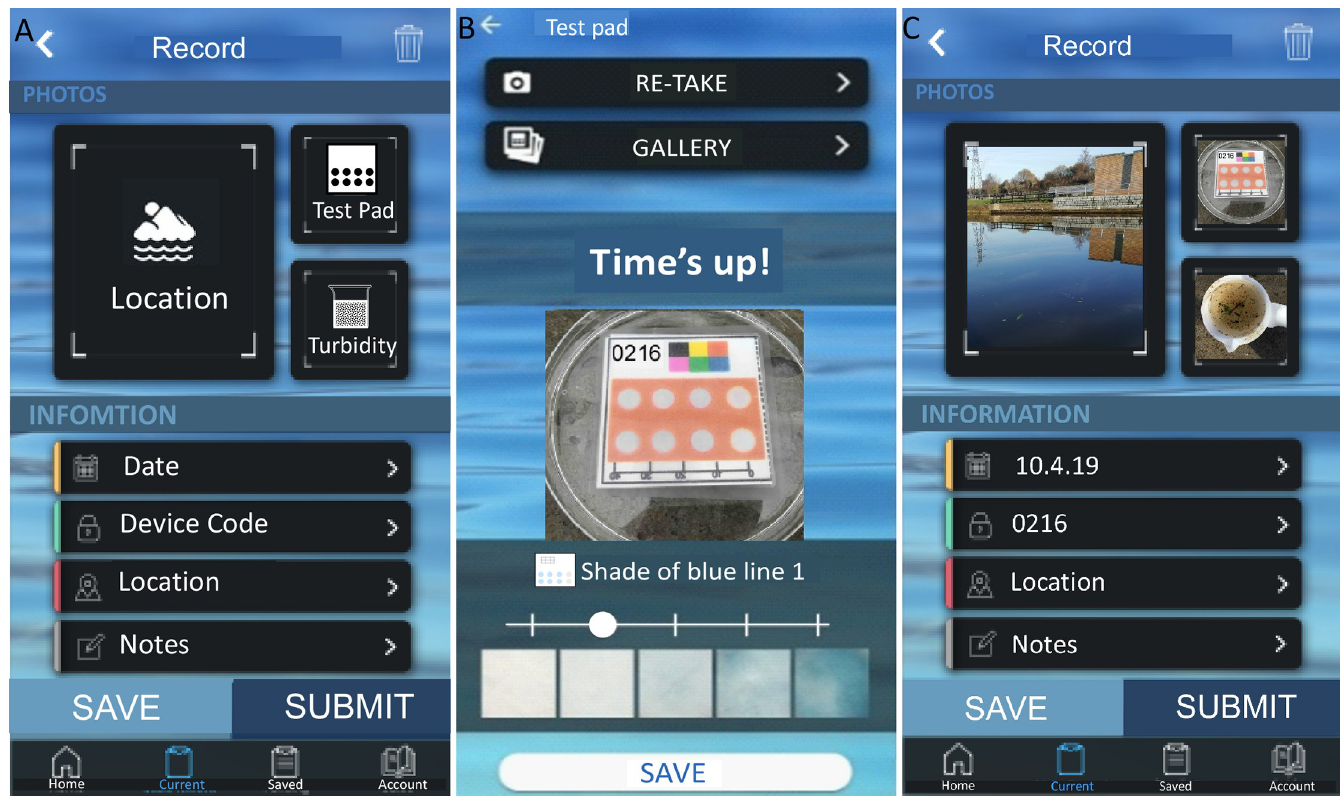
Fig 3. The RiverDip app was custom-developed to record test results in the field, with GPS location and time alongside photographs of the water quality and the surroundings. (a) The ‘record navigation page’ shows the data that needs to be completed for each sampling. (b) ‘Capturing test PAD result’ will start a 3-min timer, after which an image can be captured and uploaded. Volunteers can compare the result to a colour intensity scale bar and select the colour intensity that matches their results the closest. (c) Screenshot showing a completed result ready for submission with date, time, record code and location and images of the PAD result, location and water